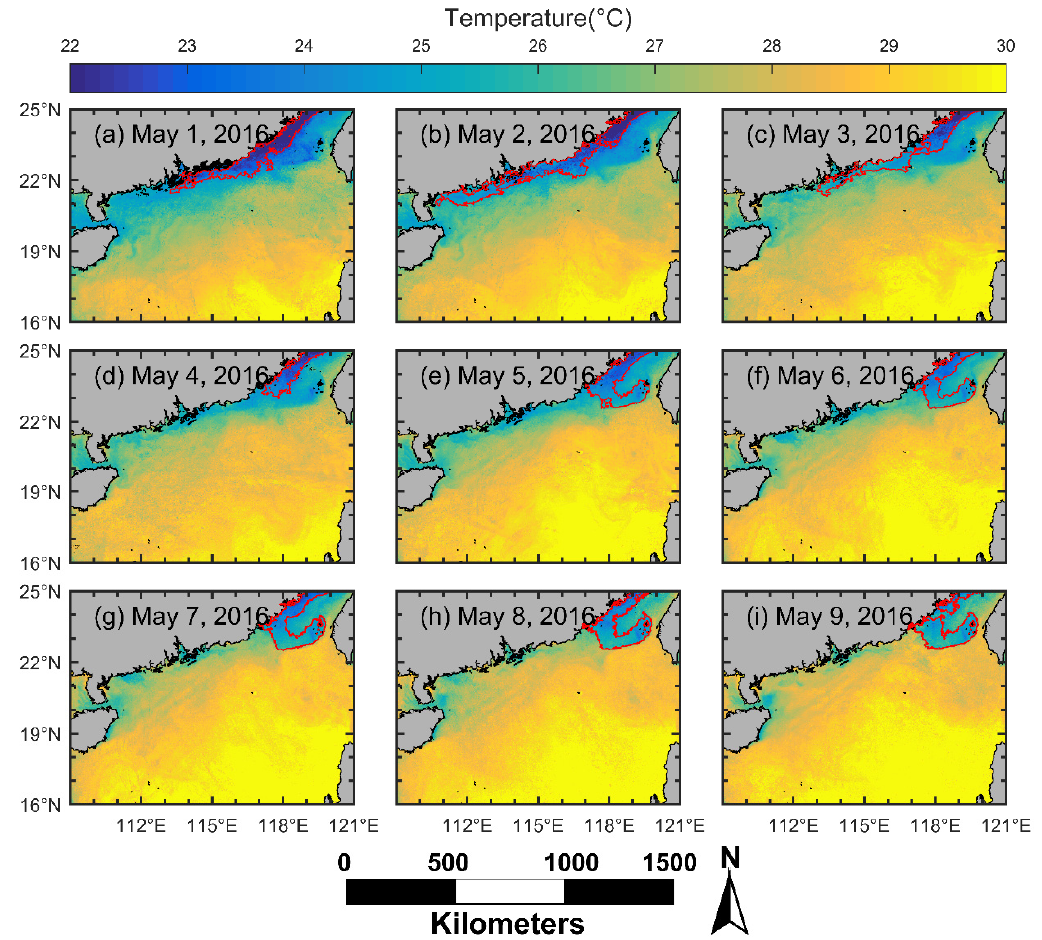
Figure 13. SST in the NSCS from 1 May to 9 May 2016. ( a – i ) represent the SST on 1 May to 9 May 2016, respectively. The areas within the red line are the low-temperature areas mapped by the TPI method (also the upwelling candidate).